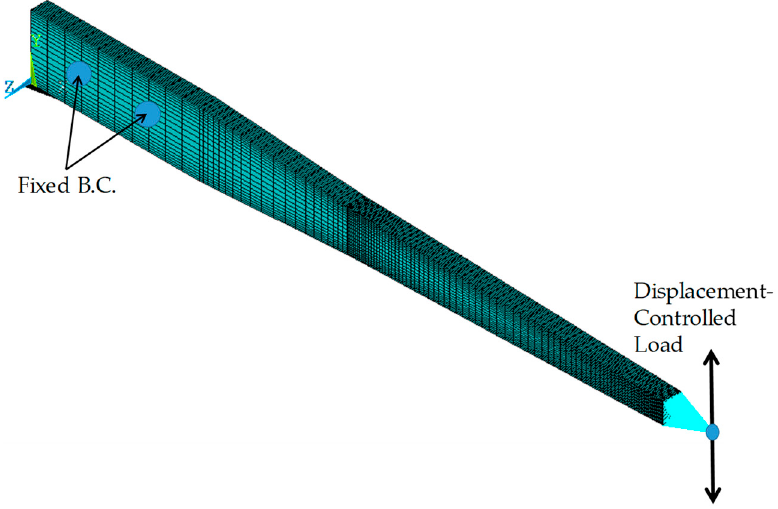
Figure 12. Finite element model of steel damper for energy dissipation analysis.